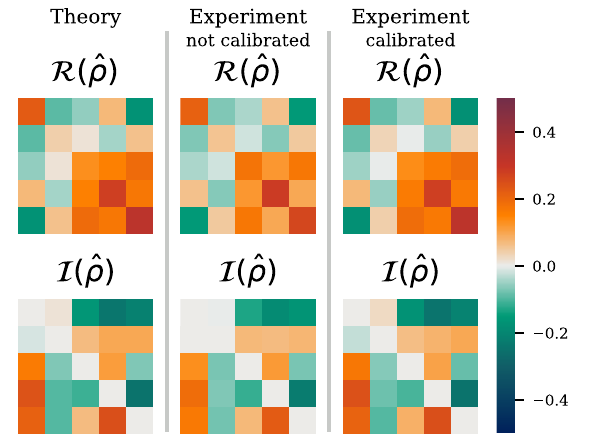
FIG. 7. Example of tomography of a random input state (mea- sured with the CCD spectrograph). The plots correspond to the real (top) and imaginary (bottom) parts of the density matrix of, from left to right, the original input state, the raw reconstructed state, and the state reconstructed with the calibration information obtained from the measurement tomography.